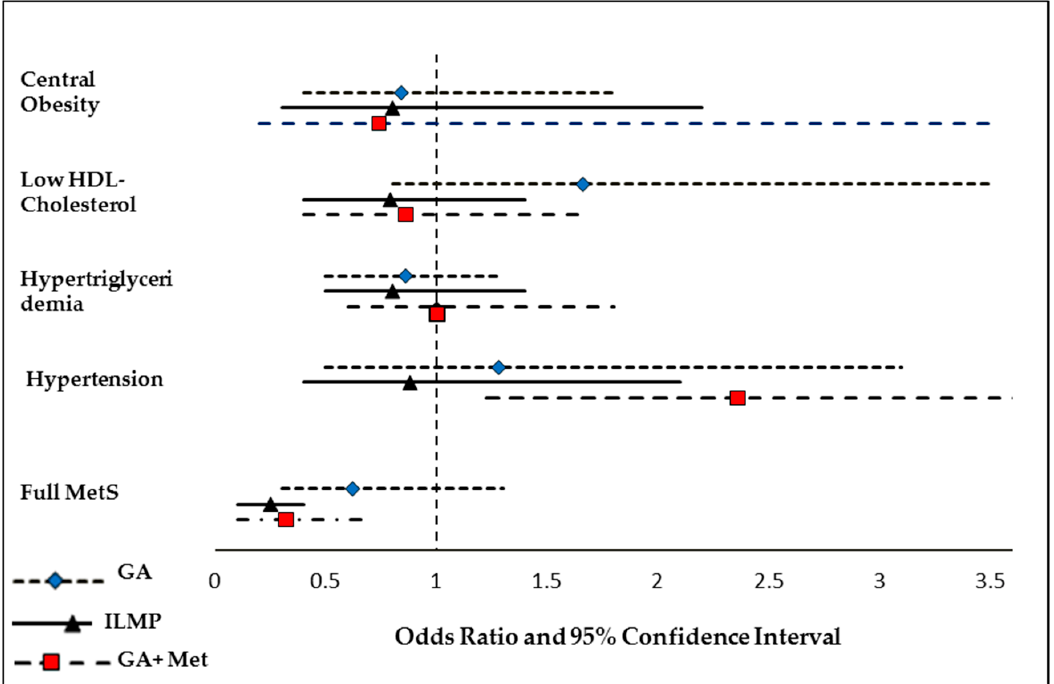
Figure 2. Odds ratio (OR) of MetS and its components for three treatment groups. The model is adjusted for age, sex, BMI and baseline covariates: waist, systolic and diastolic BP, fasting glucose, HbA1c, and vitamin D. Table 4. Intervention effects in number of MetS components and the MetS risk-score.